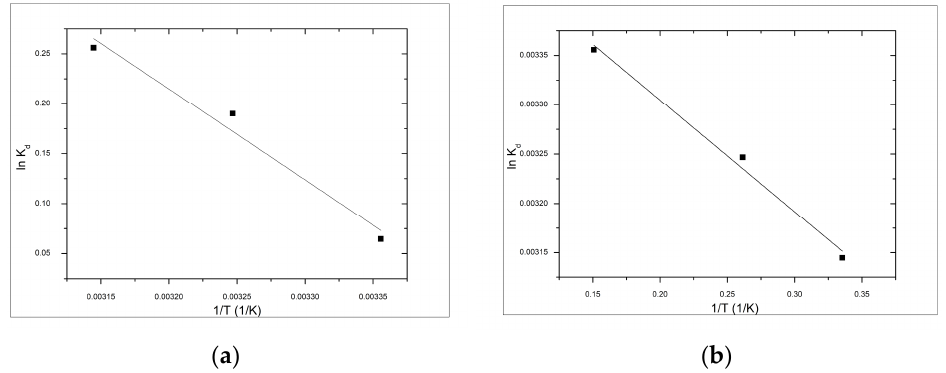
Figure 10. Van’t Hoff plots for the adsorption of As(V) onto functionalized materials ( a ) V-DEHPA-Fe and ( b ) VF-DEHPA-Fe. Table 3. Thermodynamic parameters for the adsorption of As(V) onto the functionalized materials. Tempera- ture, K